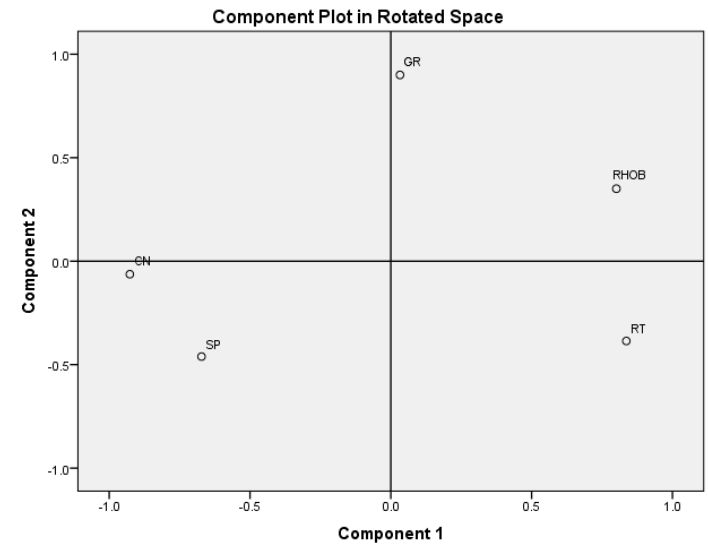
Figure 4. Component plot in a two-dimensional rotated space showing the correlation with well logs. Table 3. Correlation between well logs and selected principal components.